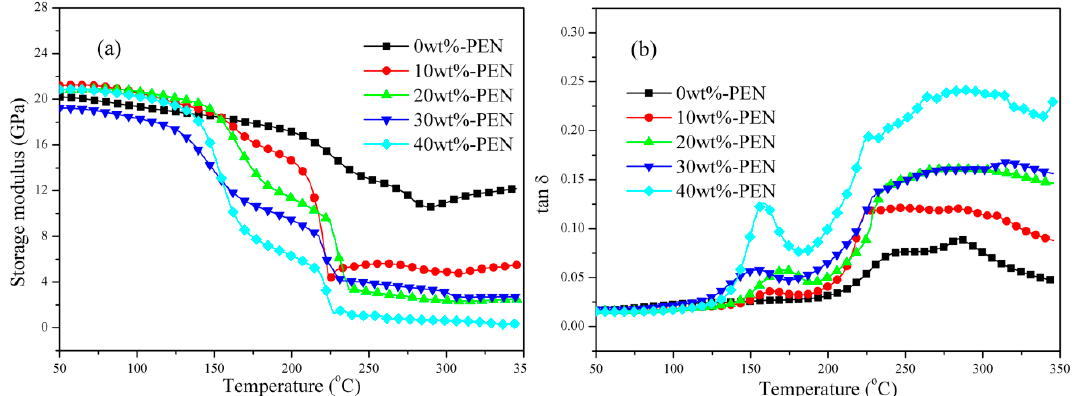
Figure 5. Dynamic mechanical analysis curves of the various composite laminates: ( a ) storage modulus and ( b ) tan δ .